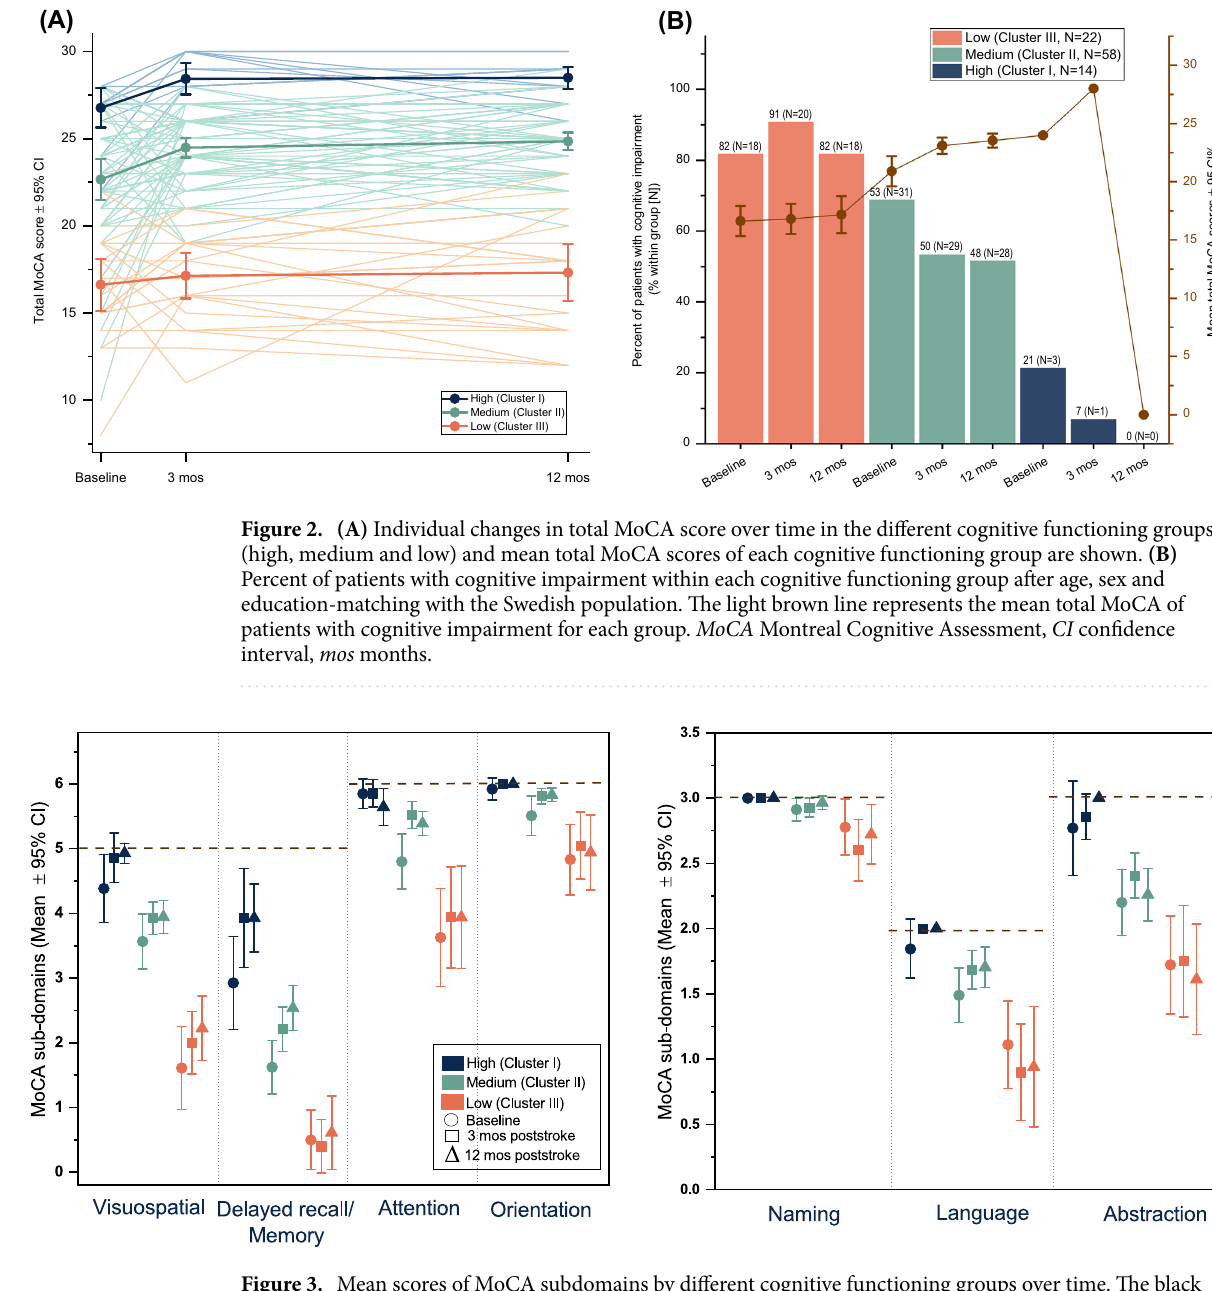
Figure 3. Mean scores of MoCA subdomains by different cognitive functioning groups over time. The black dash lines represent the maximum score of each subdomain. MoCA Montreal Cognitive Assessment, CI confidence interval, mos